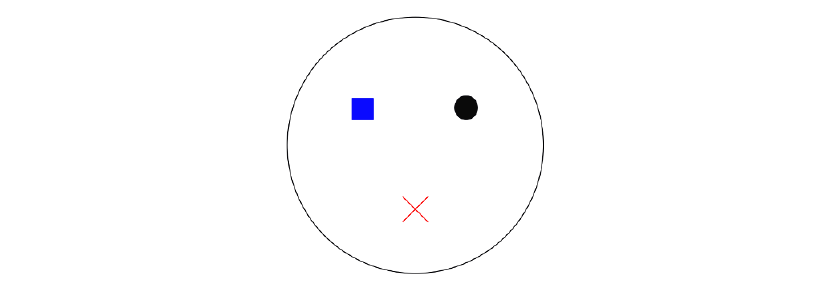
Figure 4 . An example of Argyres-Douglas matter of type g . The theory has no exact marginal deformations, and in the meantime the punctured Riemann sphere (cid:6) 0 has no complex structure